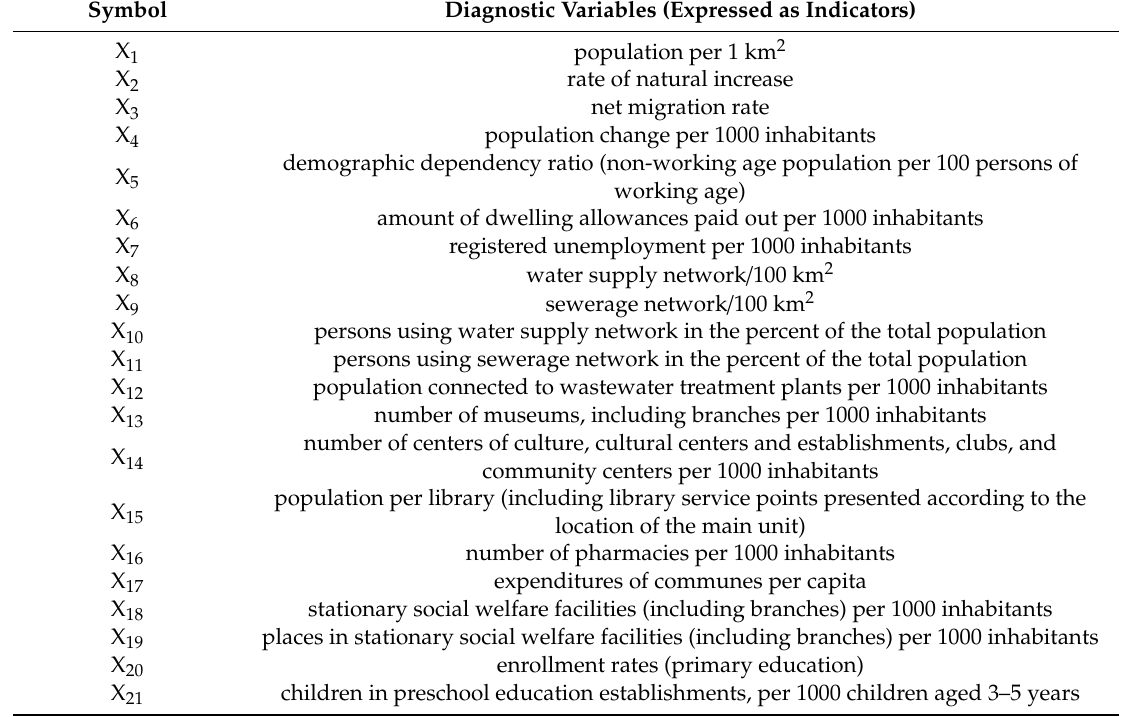
Table 1. Diagnostic variables used in the